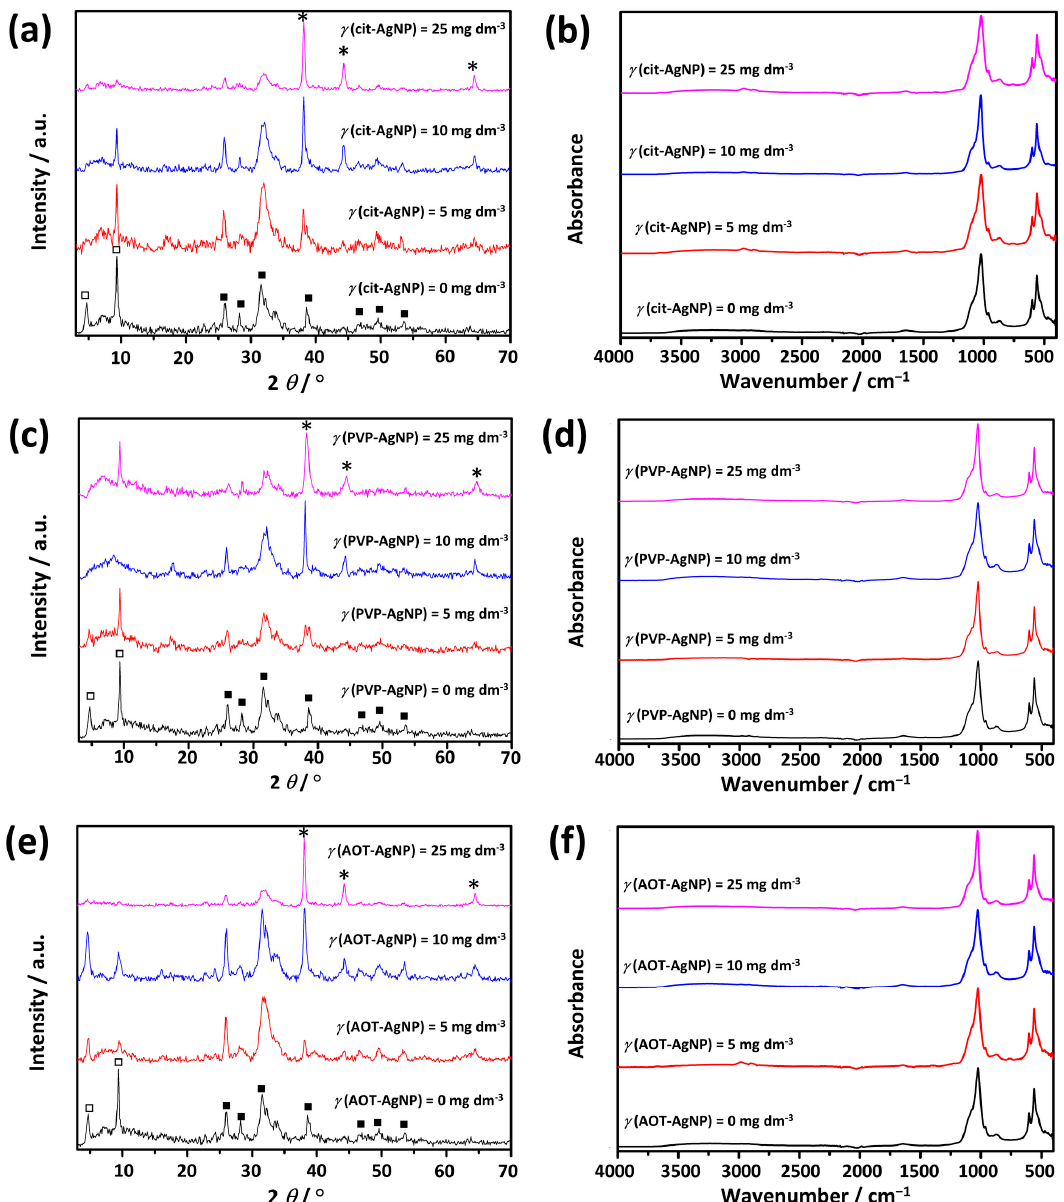
Figure 7. PXRD patterns ( a , c , e ) and FTIR ( b , d , f ) spectra of precipitates obtained after 60 min reaction time in the presence of silver nanoparticles (AgNPs) stabilized with ( a , b ) citrate (cit-AgNPs), ( c , d ) poly(vinylpyrrolidone) (PVP-AgNPs), and ( e , f ) sodium bis(2-ethylhexyl) sulfosuccinate (AOT- AgNPs). c (CaCl 2 ) = c (Na 2 HPO 4 ) = 4 · 10 ‒ 3 mol dm ‒ 3 , pH 7.4, 25 °C. □ —octacalcium phosphate, ■ — calcium deficient hydroxyapatite, *—silver nanoparticles. Characteristic phosphate and water vibration bands were observed in the FTIR spec- tra of the control system (Figure 7b). Phosphate bands were observed at 1303 cm − 1 ) , (HPO 2 − bending), 1091 cm − 1 ( ν 3a triply degenerated asymmetric stretching mode of PO 3 − 4 4 1020 cm − 1 ( ν 3c triply degenerated asymmetric stretching mode of PO 3 − ), 964 cm − 1 ( ν 1 non- 4 degenerated symmetric stretching mode of PO 3 − ), 912 cm − 1 and 869 cm − 1 (HPO 2 − stretch- 4 4 ing), 597 cm − 1 ( ν 4a triply degenerated bending mode of PO 3 − ), and 560 cm − 1 ( ν 4b triply 4 degenerated bending mode of PO 3 − . The water bands were observed at 3627–2884 cm − 1 4 (broad band) and 1637 cm − 1 [71–73]. Although there is a great similarity between the FTIR spectra of apatites and OCP exists, it is considered that the bands at around 1195 cm − 1